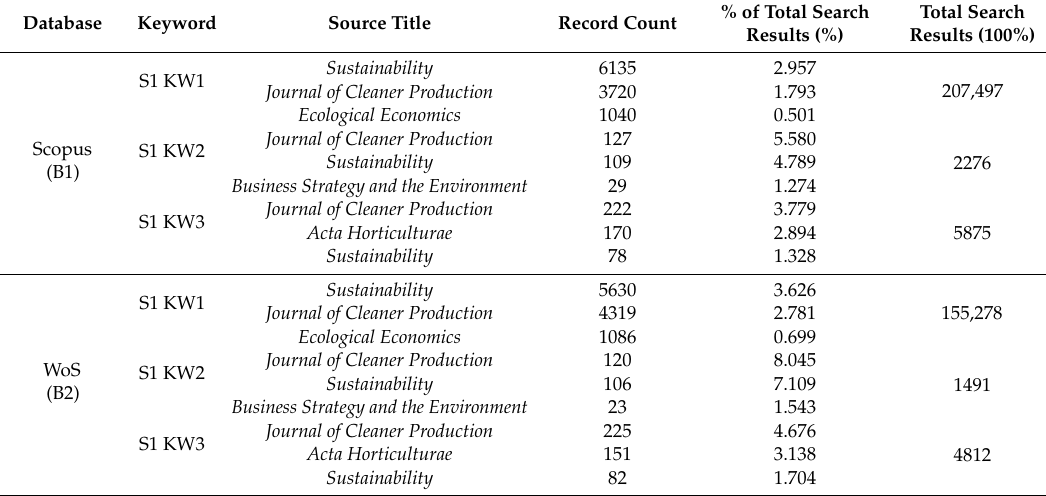
Figure 5. Types of published scientific papers for particular keywords (KW) in the segment S1 “Sustainability”. Source: Own study based on the databases: Web of Science and Scopus. Table 3. The most important scientific journals with the largest number of scientific papers which include keywords: “sustainable”, “sustainable business” or “sustainable production” (TOP 3).